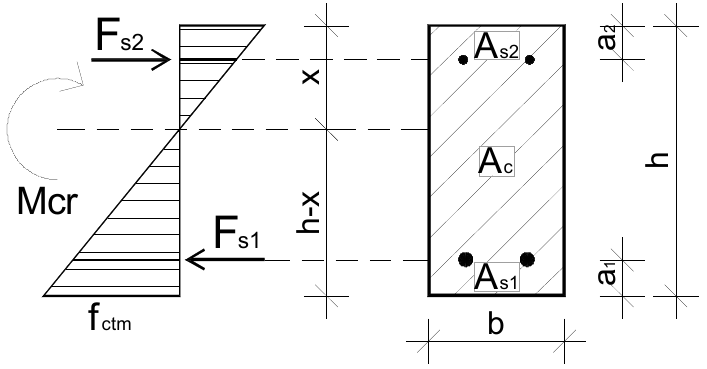
Figure 15. Theoretical concrete stress diagram—transition between phases I and II.